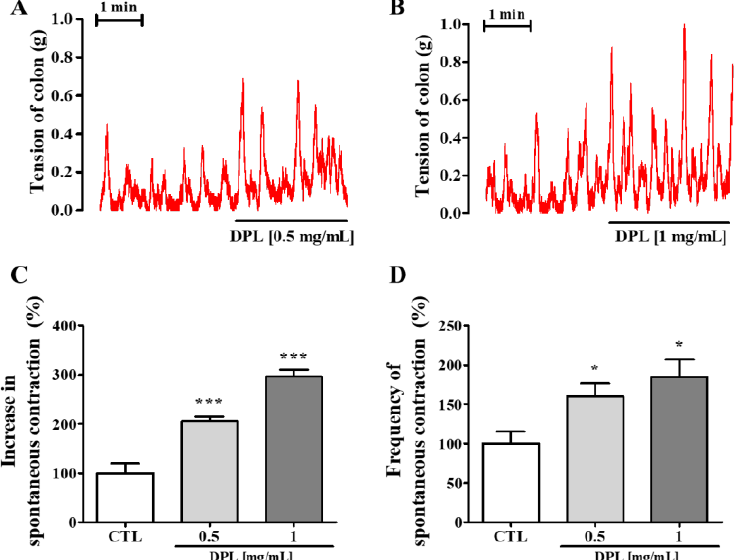
Figure 10. Physiological recordings of spontaneous contractions of the isolated rat colon showing the stimulatory effect of D. morbiferus H. Lév. leaf extract (DPL). The stimulation effects of 0.5 mg/mL ( A ) and 1 mg/mL ( B ) DPL. The amplitude of contractions was calculated as the average over 1 min ( C ). The frequency of contractions was measured over 5 min ( D ). Each bar represents the mean ± SD ( n = 8). * Significant difference at p < 0.05 and *** at p < 0.001 compared with the baseline (control; CTL).